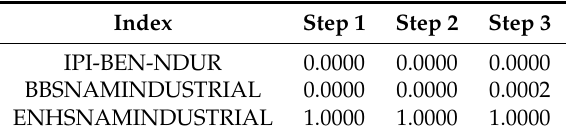
Table 14. Model confidence set hierarchy loss function is the absolute error at the end of the sample for non-durable goods model comparison α = 0.05, number of bootstrap replications = 5000 and block length = 12. The null hypothesis is that the average performance of the model in the row is as small as the minimum average performance across the remaining models. The alternative is that the minimum average loss across the remaining models is smaller than the performance of the model in the row.